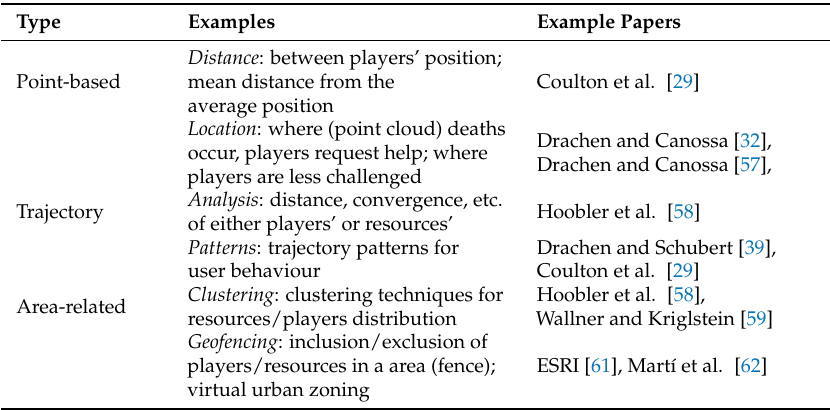
Table 8. Summary of examples of spatial